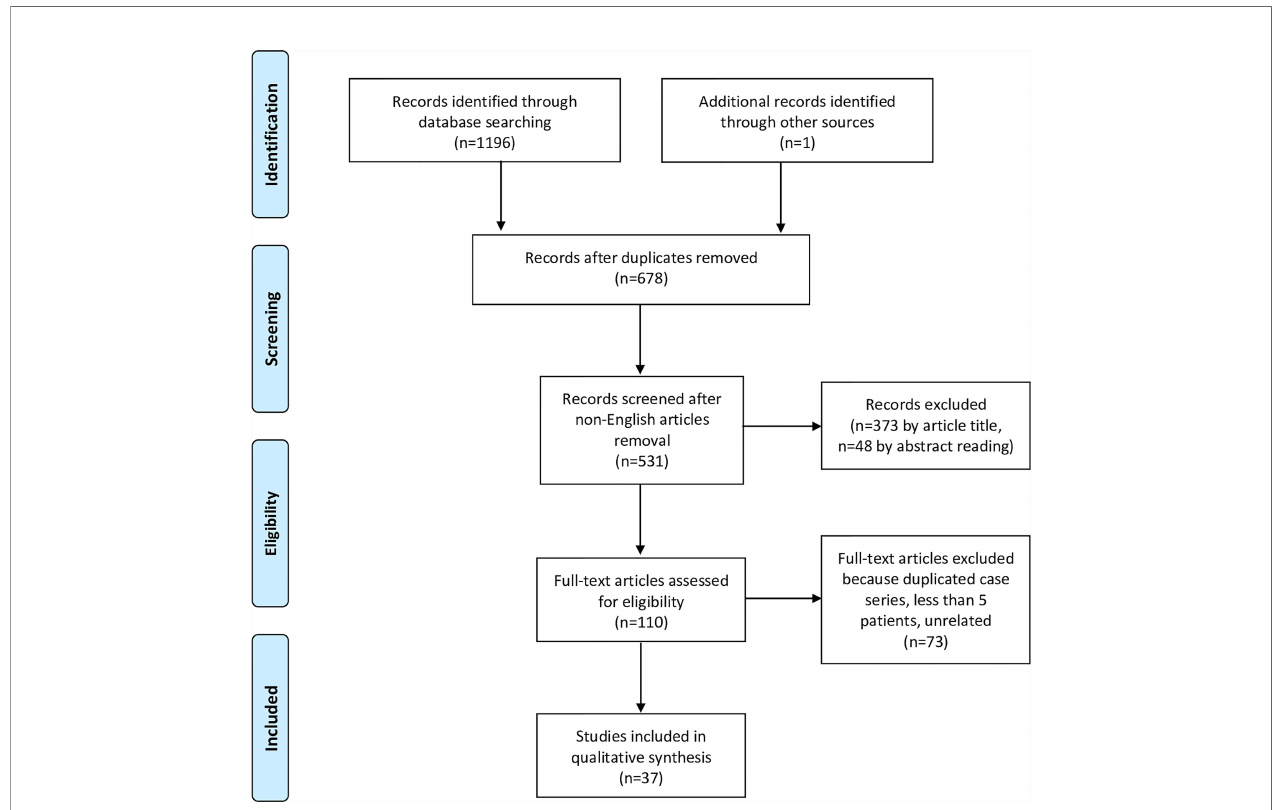
FIGURE 1 | Flowchart showing the study selection process according to the Preferred Reporting Items for Systematic Reviews and Meta-Analyses (PRISMA) statement.